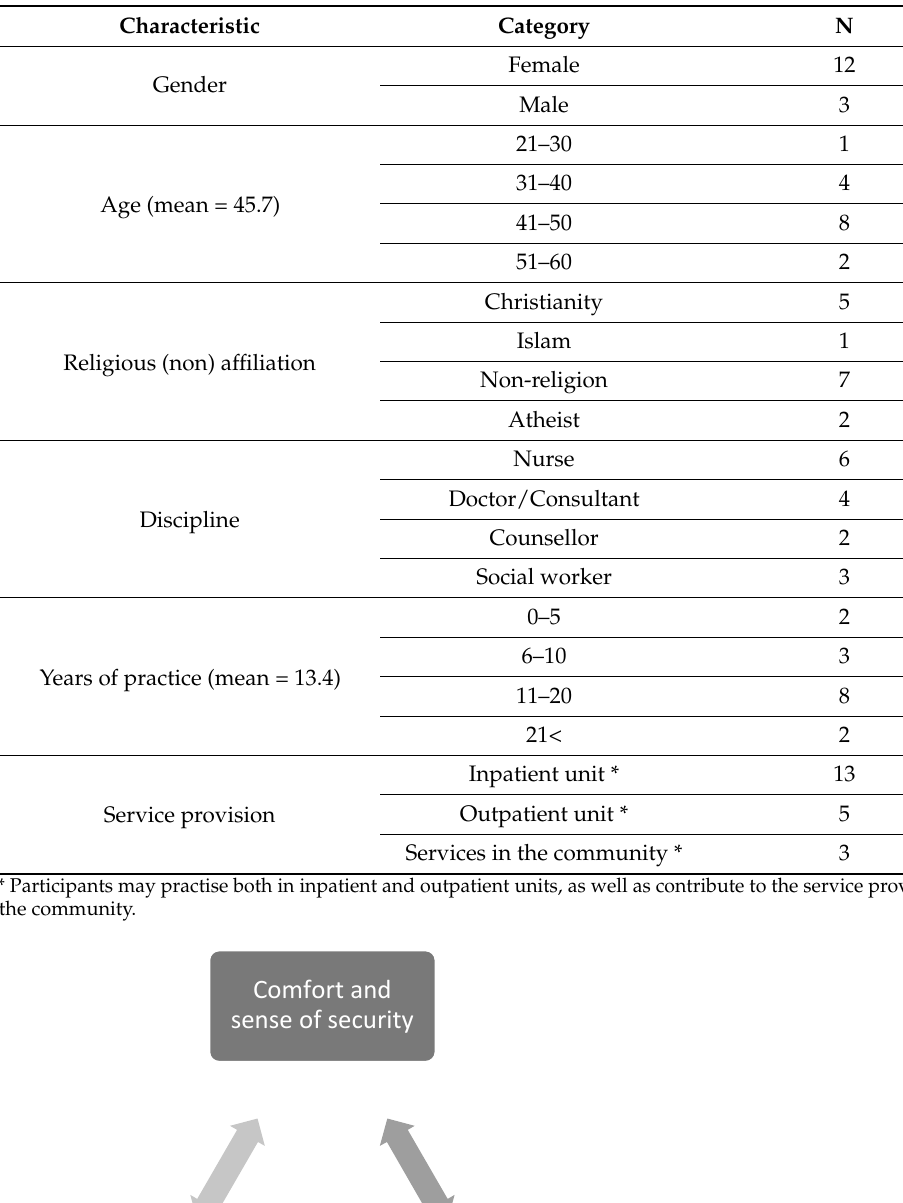
Table 1. Respondents’ characteristics.